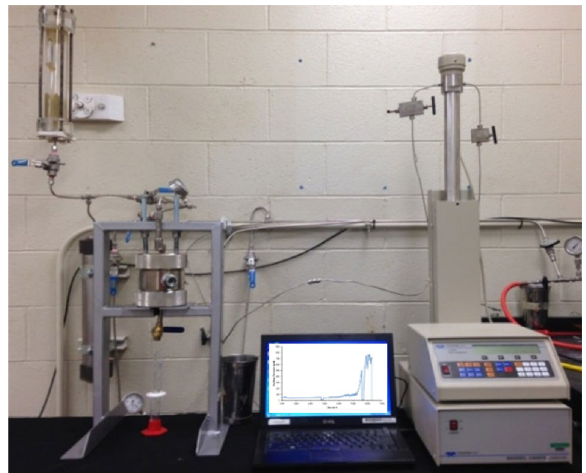
Fig. 1 High-pressure LCM testing apparatus (Alsaba et al.